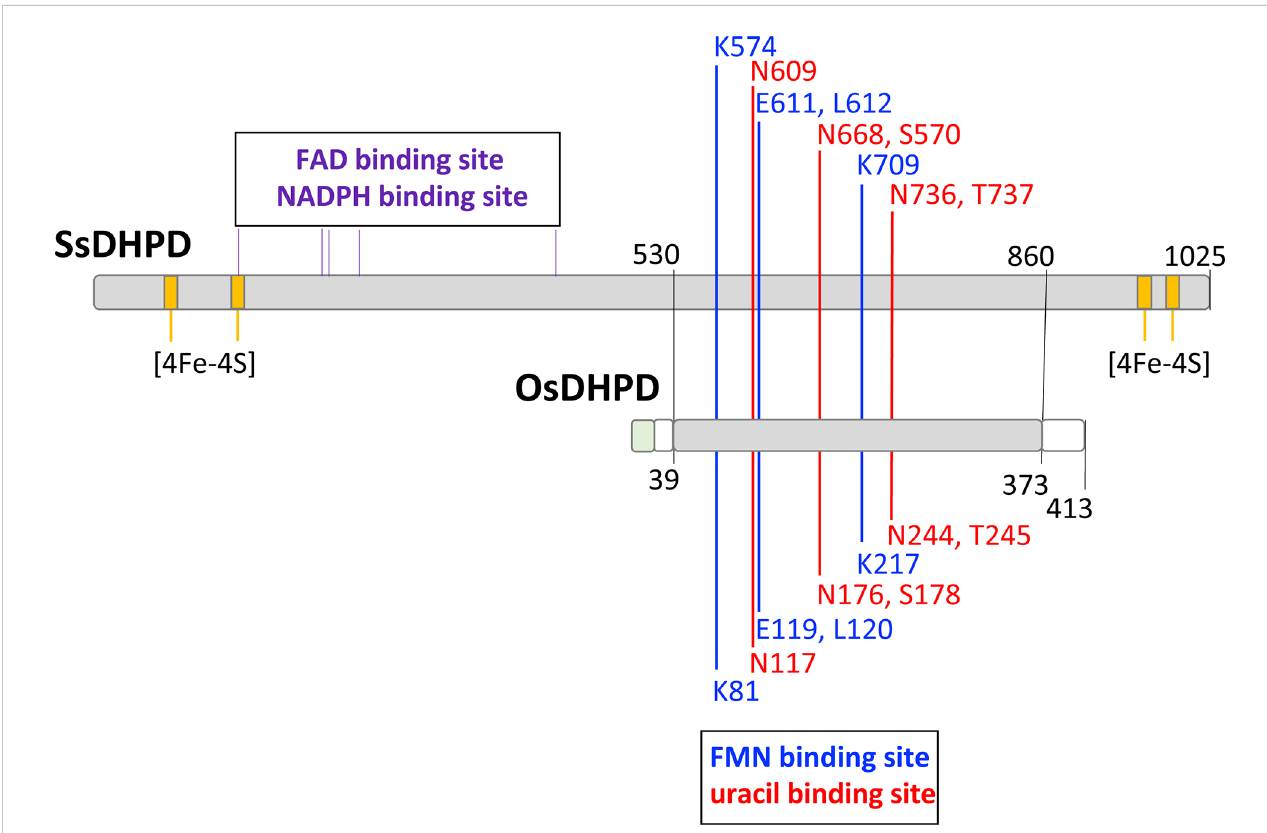
FIGURE 1 A schematic alignment of the mammalian DHPD and OsDHPD. The upper bar represents SsDHPD (Genbank U09179.2), and shows approximate locations of residues involved in binding cofactors and substrate, that are identi fi ed in the crystal structure (Dobritzsch et al., 2001). Position of residues interacting with FMN are indicated with vertical blue lines, positions of residues interacting with substrate are shown with vertical red lines, and the positions offour iron sulfur cluster are shown in yellow. The positions of residues involved in FAD and NADPH binding are indicated by the vertical black lines above the bar. The lower bar represents OsDHPD, and the region of homology with SsDHPD is highlighted in gray. The conserved FMN and uracil binding residues are shown below the bar. Regions that are not homologous are shown in white and green, the latter indicating the chloroplast targeting